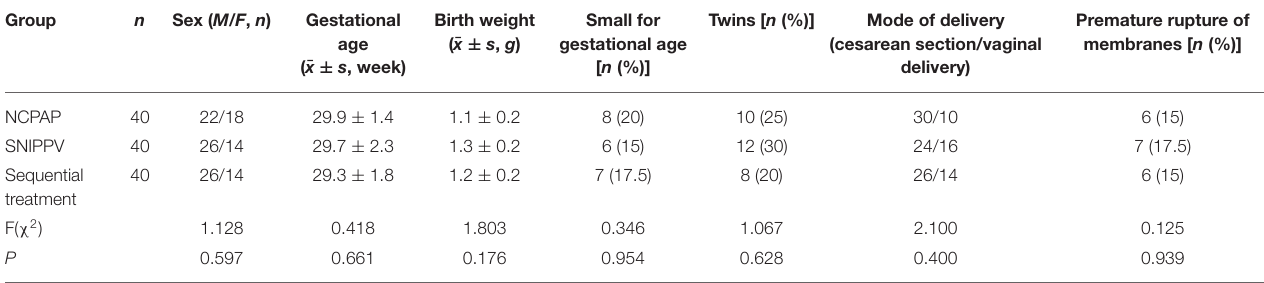
P refers to three groups of comparison: NCPAP, SNIPPV and Sequetial treatment. The comparison was conducted among the three groups. If P < 0.05, a pairwise comparison was further performed between every two groups. If P > 0.05, it means that there was no statistical difference among them, so no further pairwise comparison would be performed.